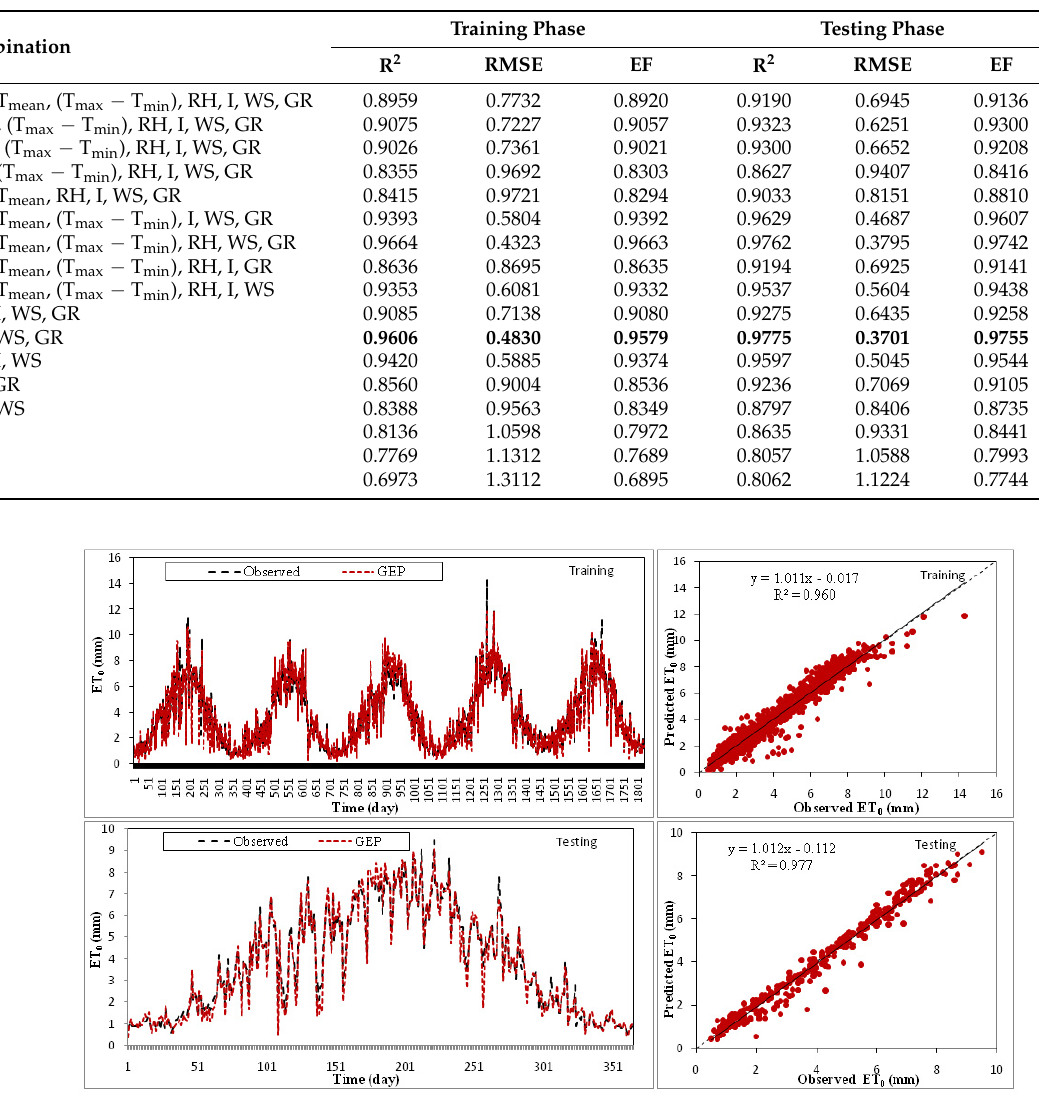
Table 7. Statistical criteria for an estimation of ET 0 using different input variables for GEP.